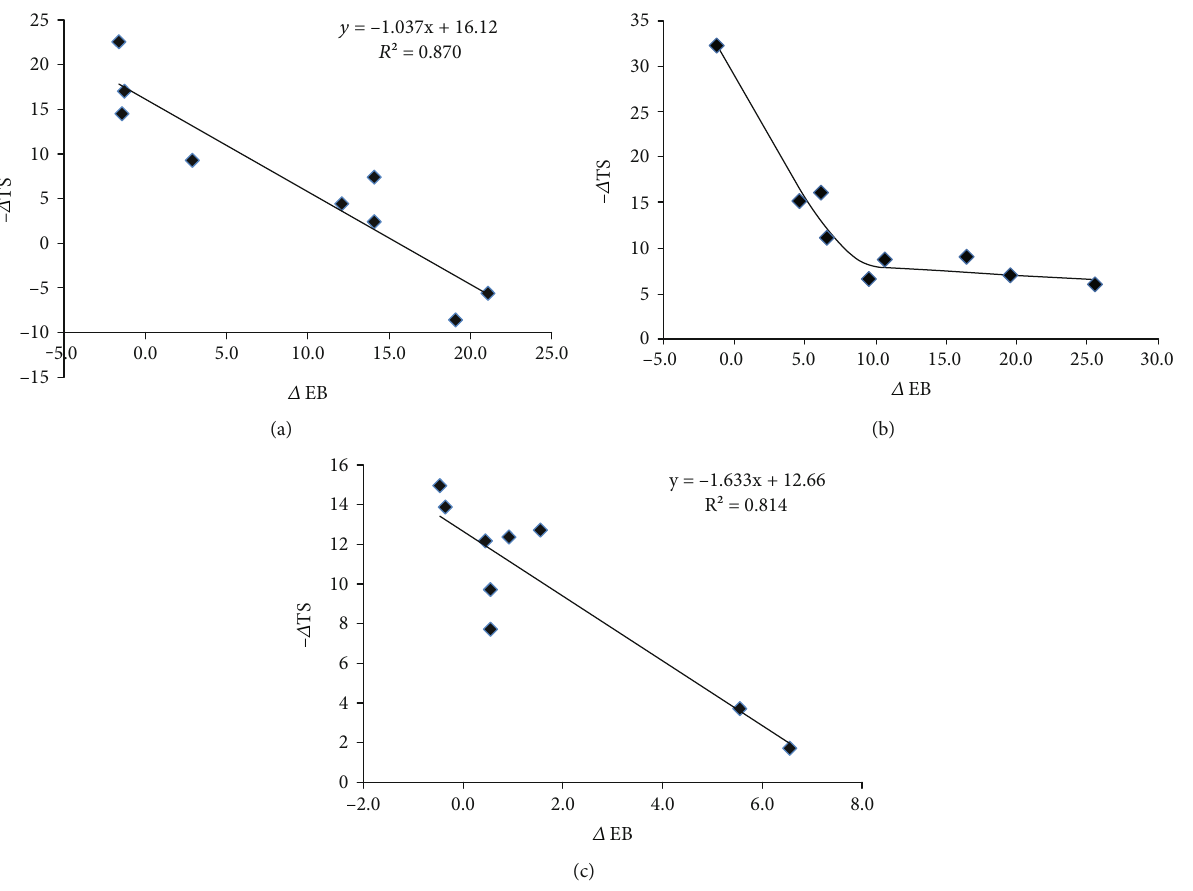
Figure 1: Di ff erence in tensile strength between polymer-EO fi lm and polymer control ( Δ TS) versus di ff erence in elongation at break between polymer-EO fi lm and polymer control ( Δ EB). (a) CA (data fi tted to a linear equation), (b) CAP (data showing an asymptotic horizontal behavior), and (c) CAB (data fi tted to a linear equation). Table 5: Water vapor permeability data (in units of mg-m-kPa-h-m 2 ) for cellulose ester-EO fi lms.